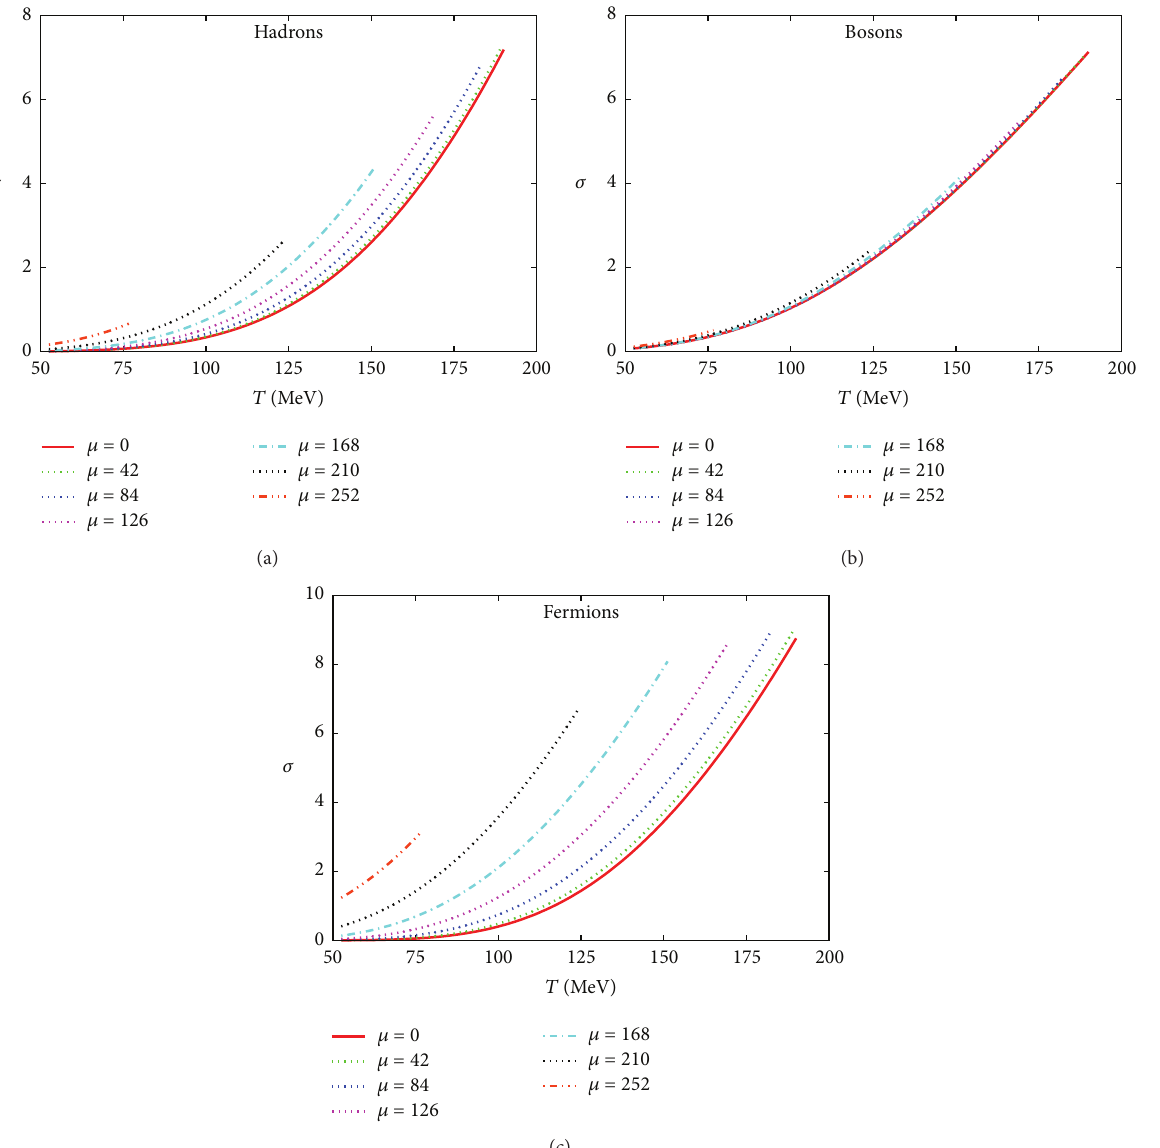
Figure 2: Results for 𝜎 in hadronic (a), bosonic (b), and fermionic (c) resonances are given in dependence on 𝑇 for various baryon chemical potentials (given in